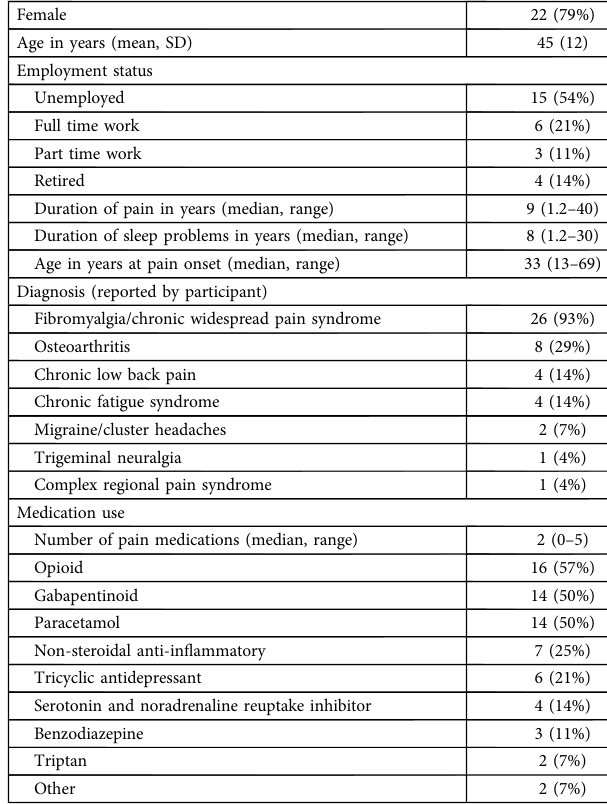
TABLE 1 Participant background and demographics ( n